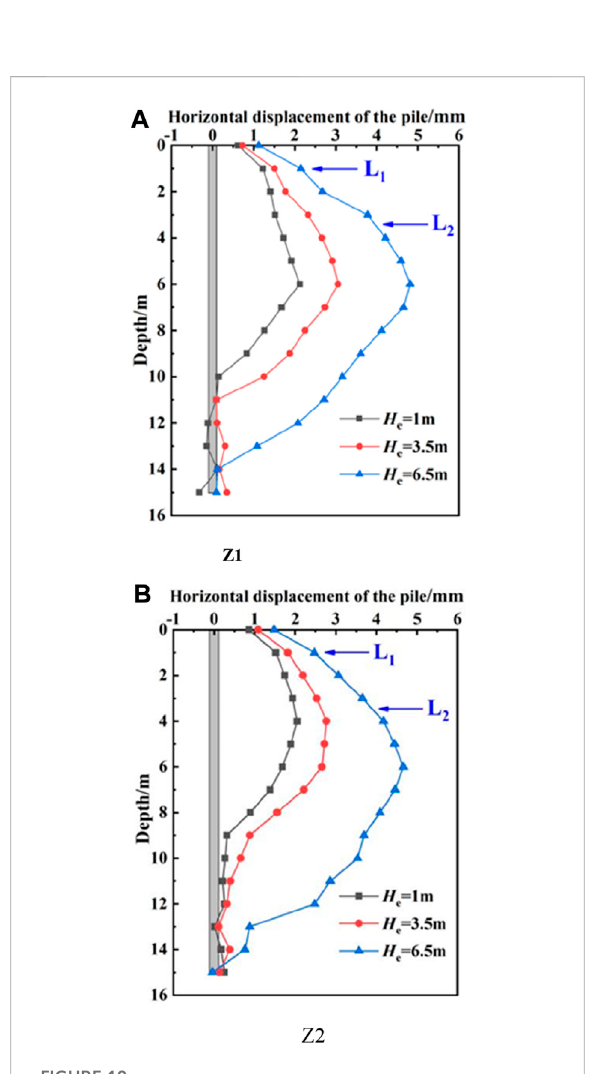
FIGURE 10 Horizontal displacement curve of retaining pile. (A) Z1. (B)